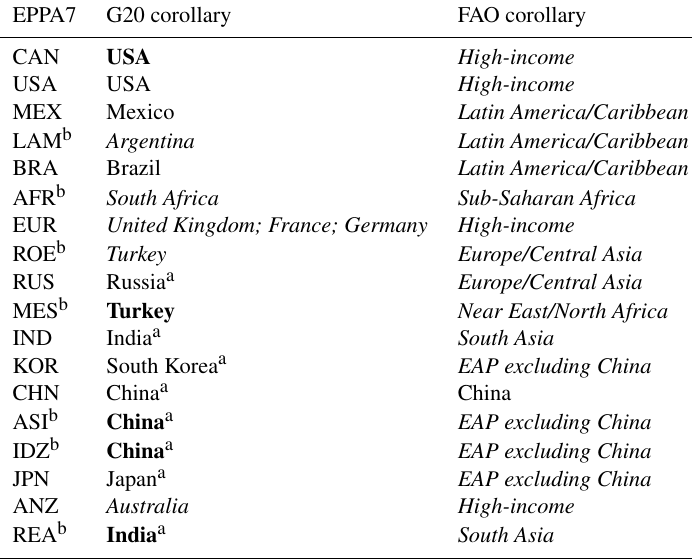
Table C4. Mapping from NH 3 data sources to EPPA7